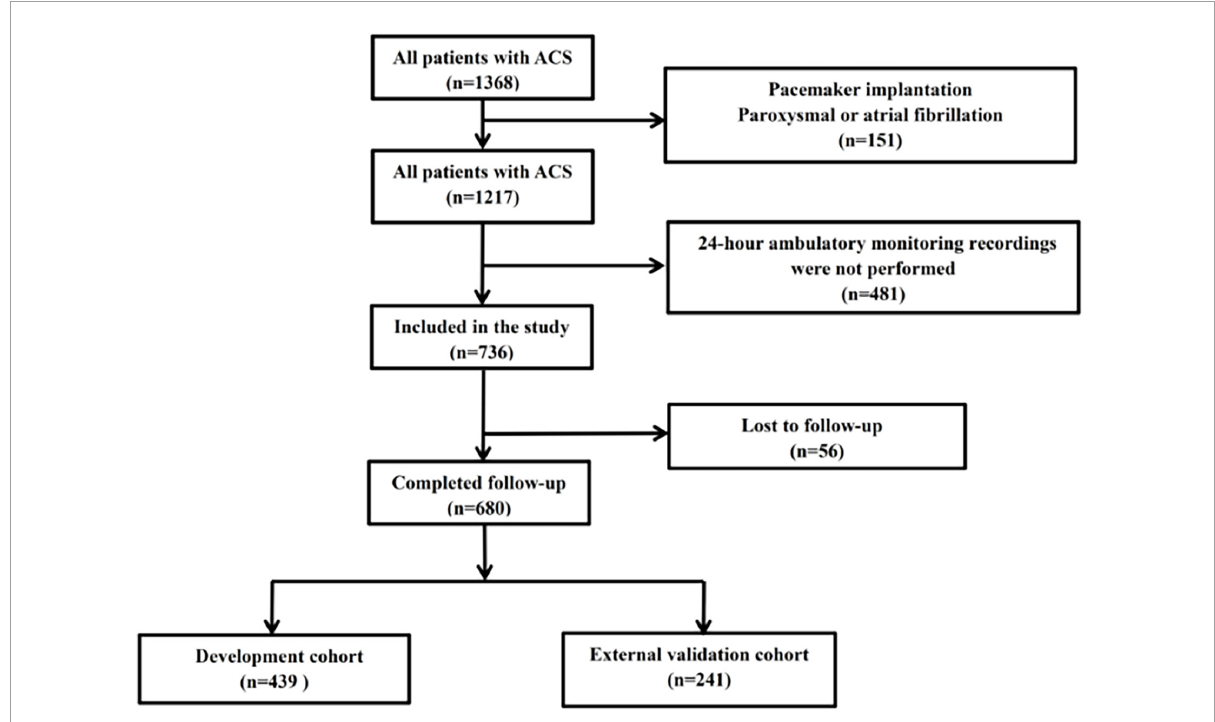
FIGURE1 Disposition of patients with ACS ( n = 1,368), and establishment of the development cohort ( n = 439) and external validation cohort ( n = 241).